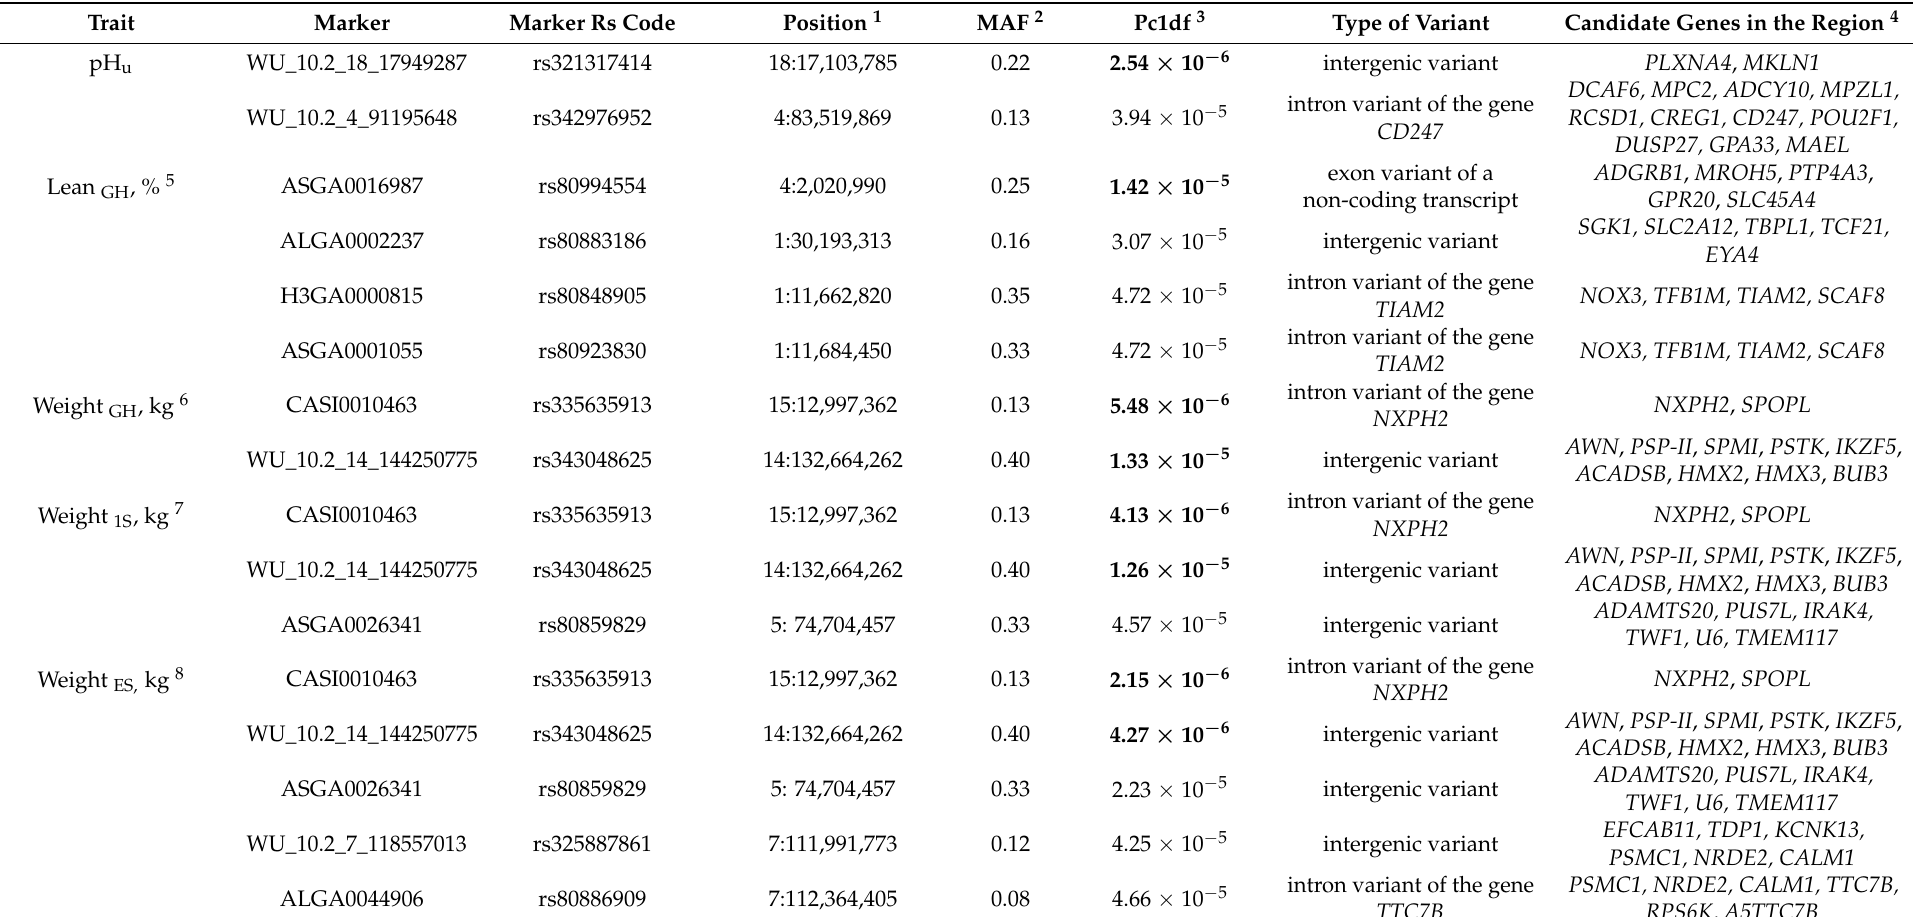
Table 2. The list of the significant markers, with the associated traits, the marker position, the type of variant, and the list of the candidate genes in the regions flanking the significant markers. Chromosome-wide significant markers are in